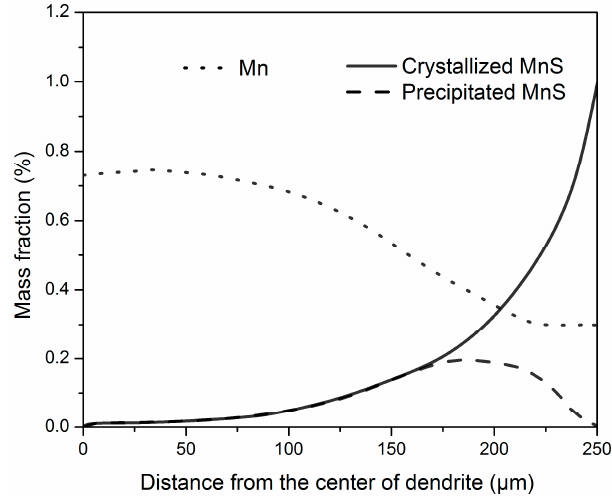
Figure 4. Calculated distributions of MnS and Mn in dendrites at 1300 °C [94].